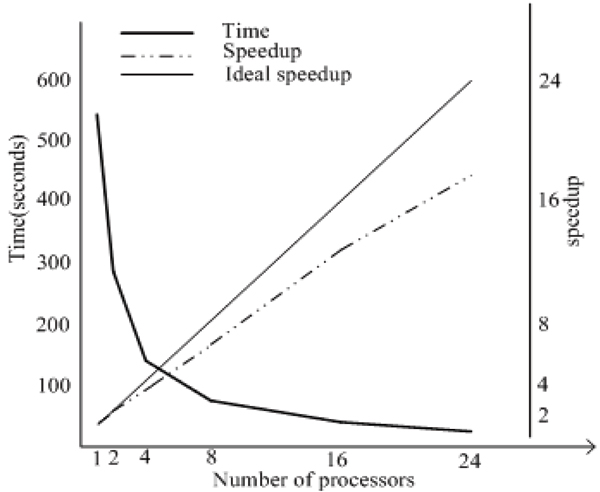
The execution time and speedup of PMC-SVM on sweetgum with Dataset 2 (Mnist1_scale).